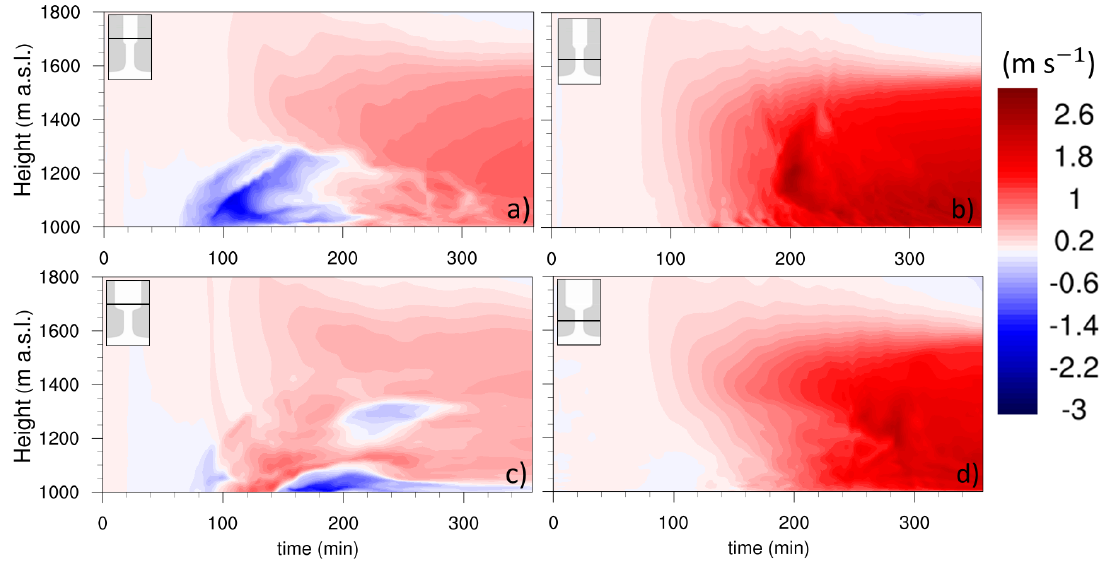
Figure 2. Hovmöller diagrams of the evolution of the along-valley flow speed for P1, at 10 km ( a ) and 16 km ( b ) from the beginning of the valley; and for P2, at 10 km ( c ) and 16 km ( d ) from the beginning of the valley. The flow speed is averaged over the valley-floor width in x -direction, and over 1 km along the y -direction. Positive (red) values correspond to a down-valley flow while negative values (blue) to an up-valley flow. The y -position of either figure is indicated in the sketch in the upper-left corner of each